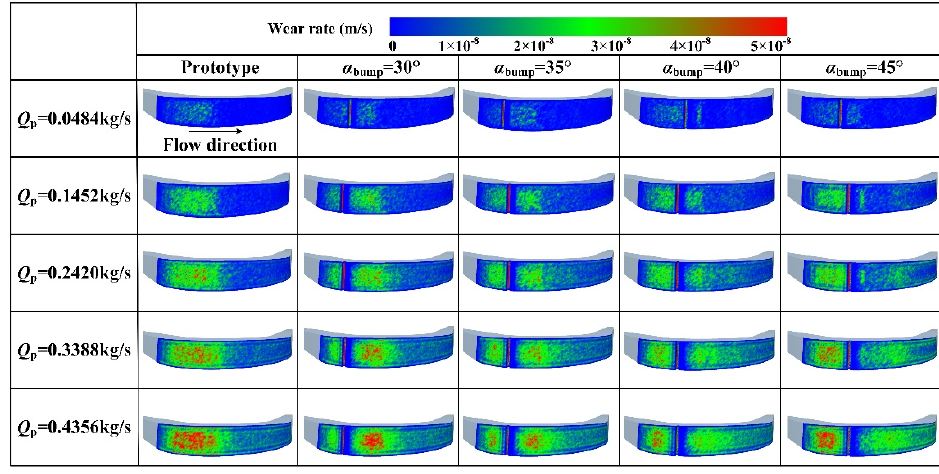
Figure 11. Wall surface wear rate for different particle mass flow